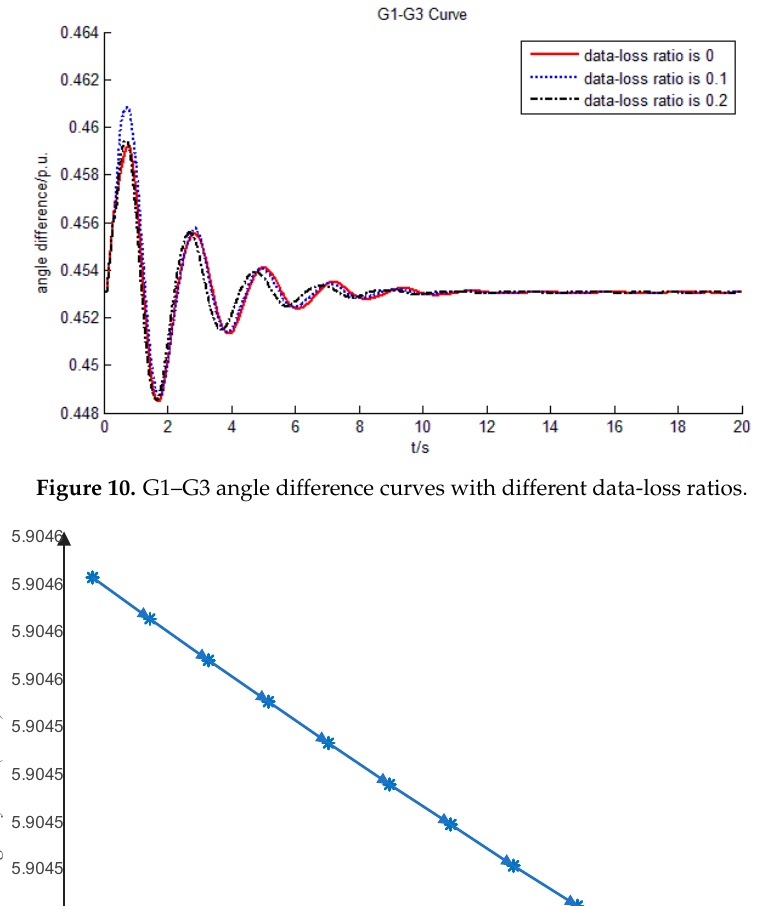
Figure 9. Modal trajectory regulated by time-delay: ( a ) 0 s to 0.24 s, ( b ) 0.28 s to 0.4 s.